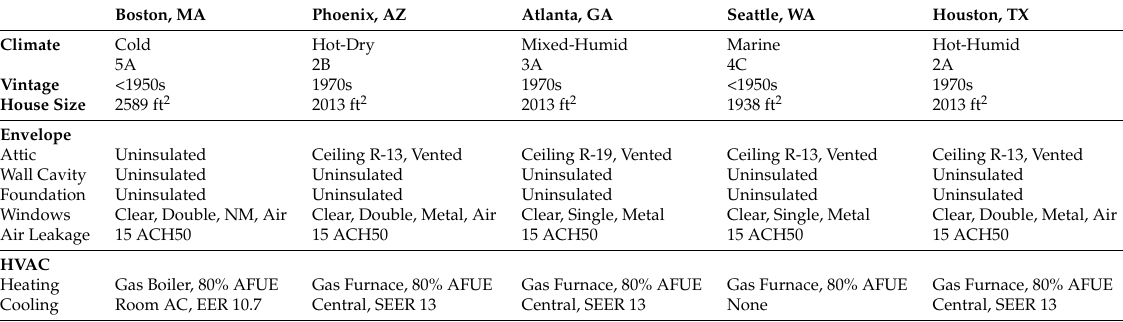
Table 6. Summary of house model constructions.